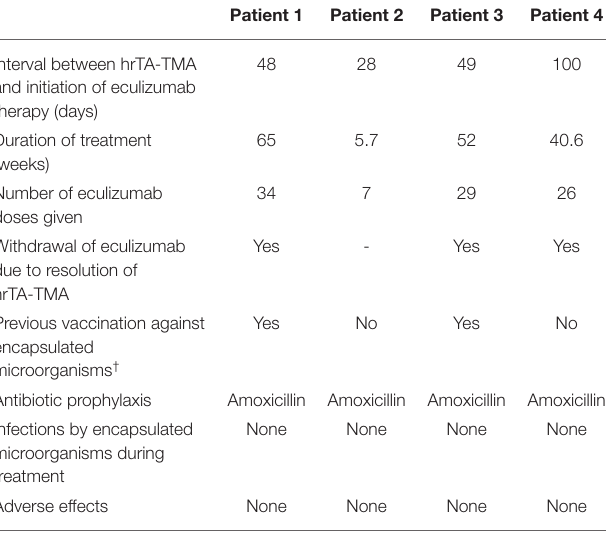
TABLE 3 | Eculizumab treatment data.